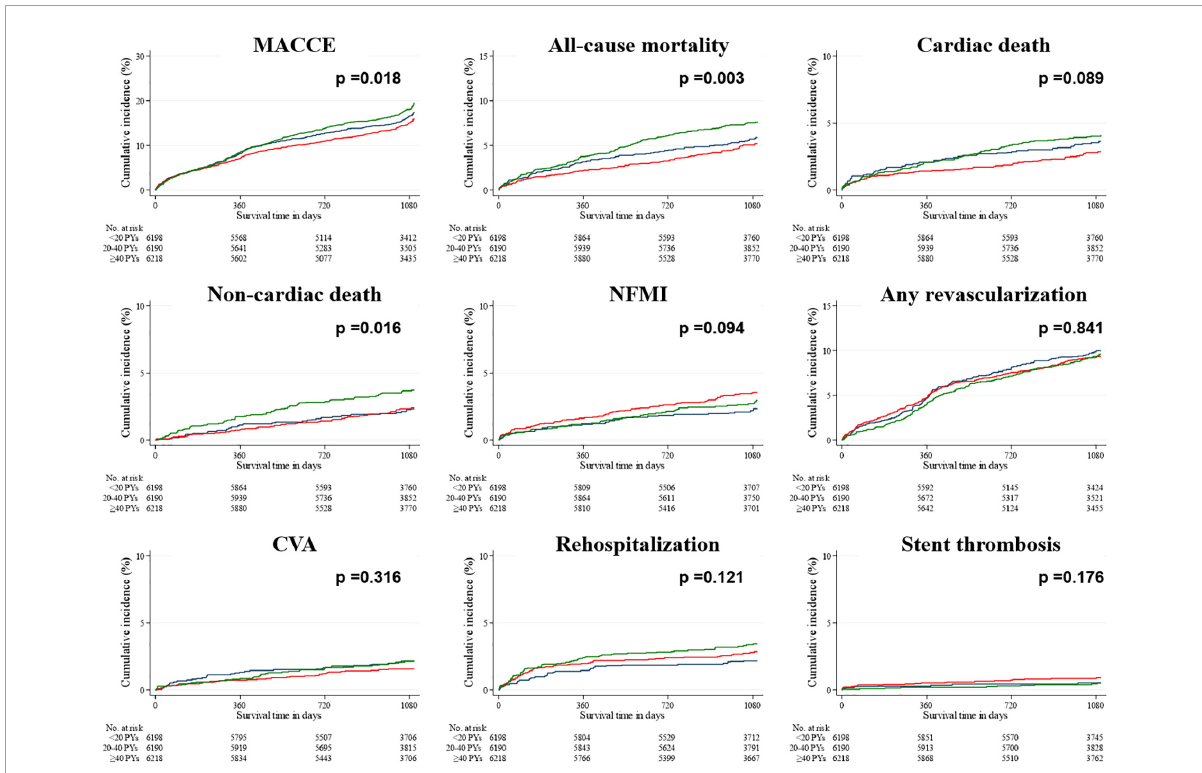
FIGURE3 Rates of primary and secondary outcomes for the smoking population after a 3-year follow-up (after IPTW adjustment). The Kaplan–Meier survival curves for cumulative event rates are illustrated according to the baseline smoking status. Blue line indicates the group with < 20 PYs. Red line indicates the group with 20–40 PYs. Green line indicates the group with ≥ 40 PYs. CVA, cerebrovascular accident; IPTW, inverse probability of treatment weighting; MACCE, major adverse cardiac and cerebrovascular event; NFMI, non-fatal myocardial infarction; PY, pack